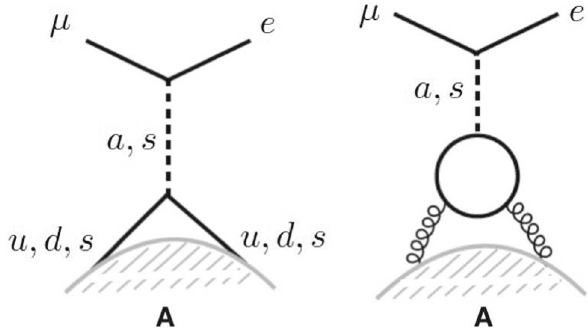
Fig. 12 Feynman diagram showing A μ → A e conversion